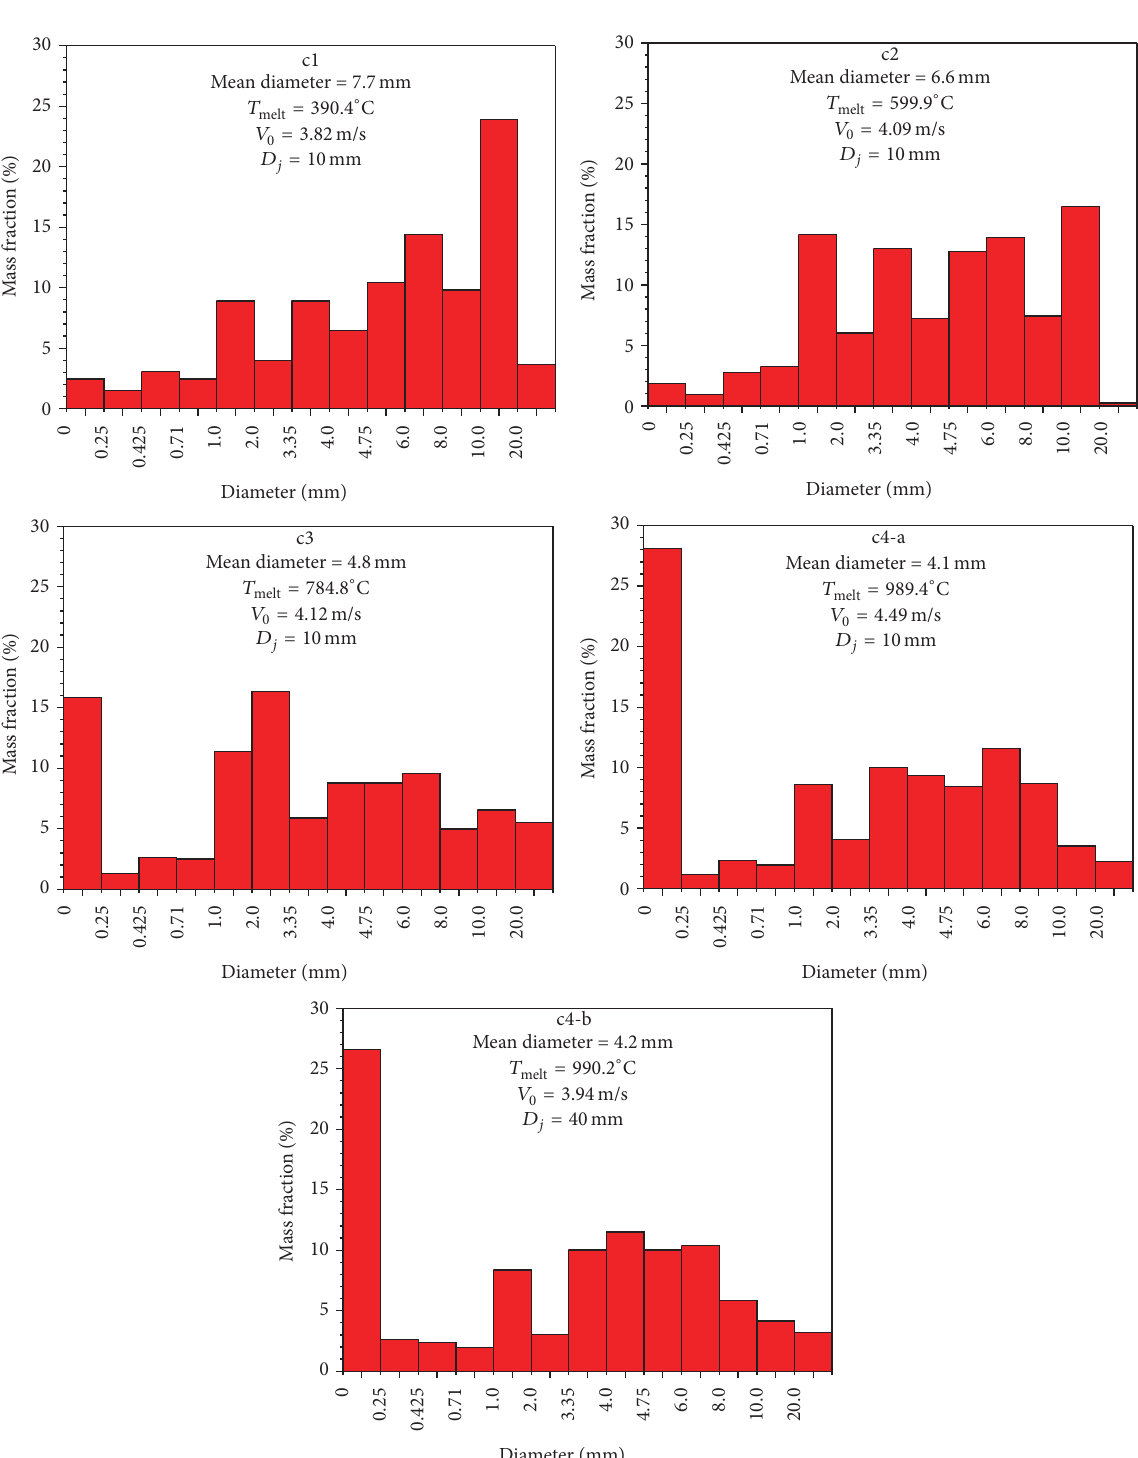
Figure 9: Statistic of the mass fraction for the five